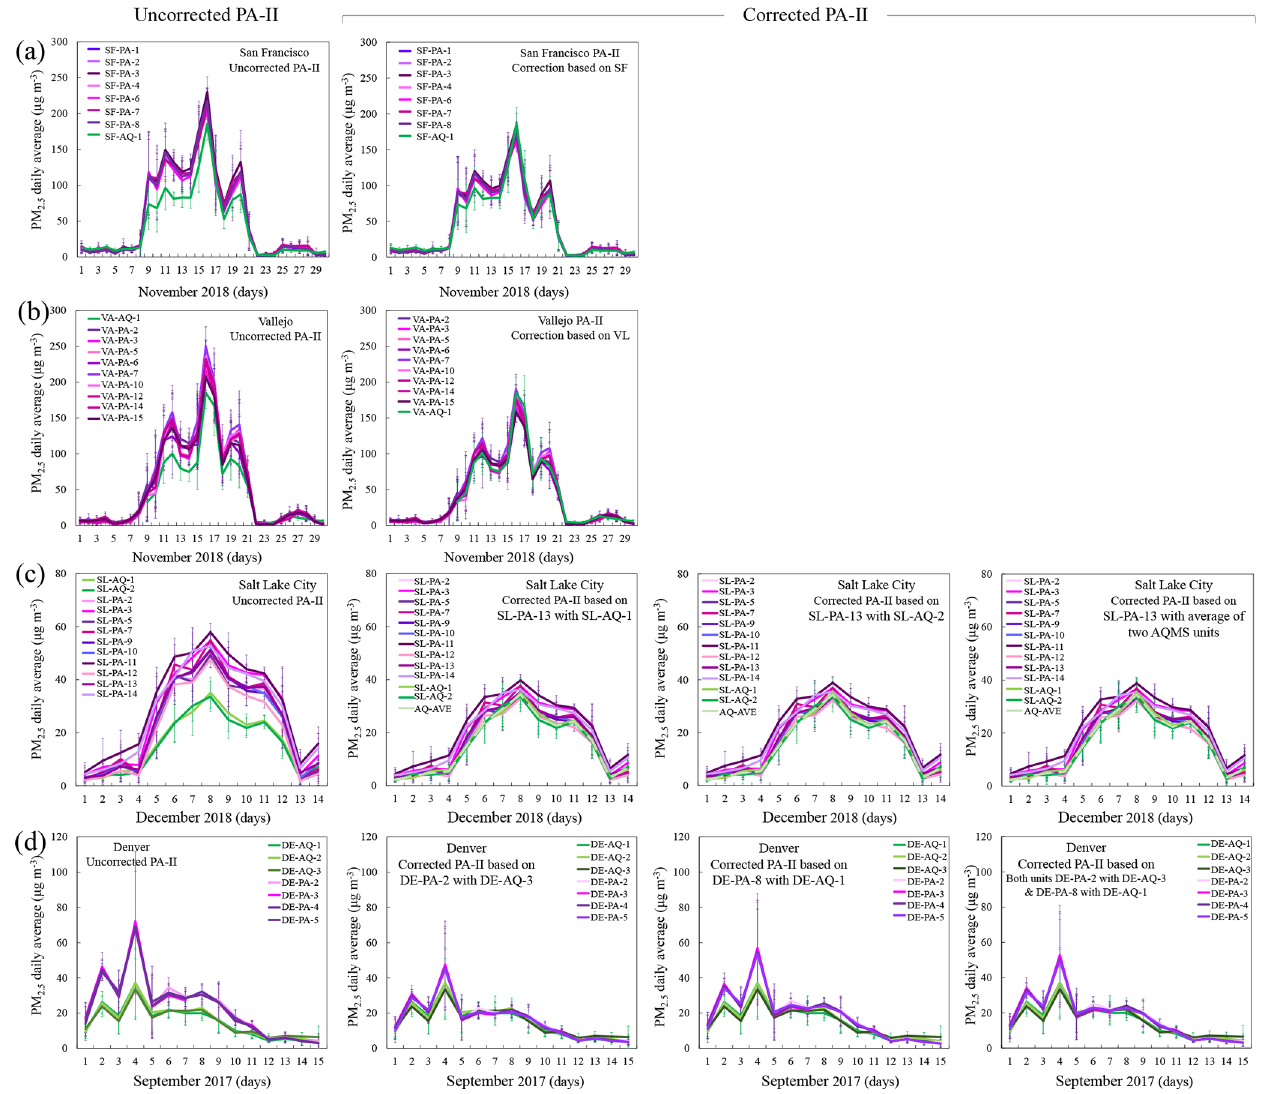
Figure 6. Daily measurements of PM 2 . 5 at (a) San Francisco and (b) Vallejo during the November 2018 wildfire (UTC time). Daily PM 2 . 5 measurements at Salt Lake City during 1–14 December 2018 during inversion (c) . Daily PM 2 . 5 measurements at Denver during haze, 1– 15 September 2017 (d) . Each location shows measurements before the PA-II PM 2 . 5 measurements were corrected and after each of the correction options. AMQS units are represented by the different green lines and the PA-II units are represented by the different purple lines. Bars represent the standard deviation per day